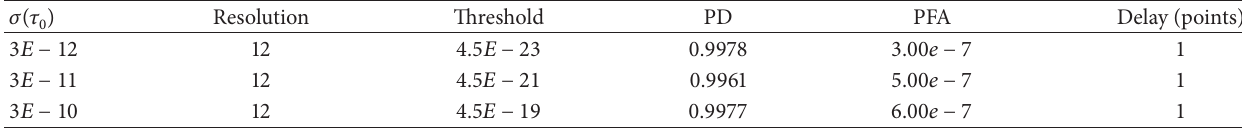
Table 8: Detection performance of phase jumping for different clock stability.